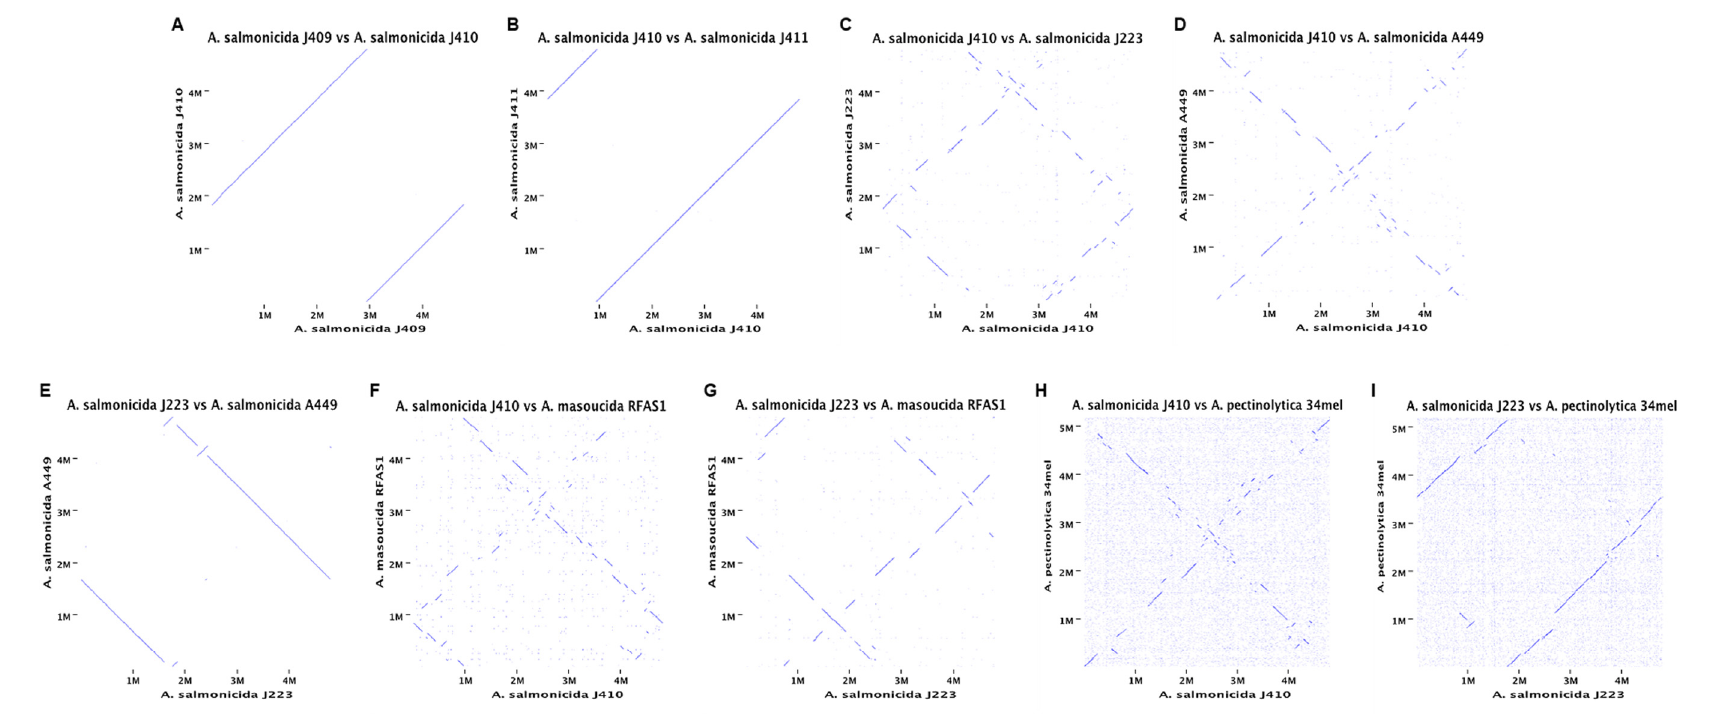
Figure 6. Whole-genome comparison synteny analysis. Genome sequences alignment to identify homology by synteny. ( A ) Comparison between A. salmonicda J409 vs. J410; ( B ) Comparison between A. salmonicda J410 vs. J411; ( C ) A. salmonicida J410 vs. A. salmonicida J223; ( D ) A. salmonicida J410 vs. A. salmonicida A449; ( E ) A. salmonicida J223 vs. A. salmonicida A449. ( F ) A. salmonicida J410 vs. A. masoucida RFAS1; ( G ) A. salmonicida J223 vs. A. masoucida RFAS1; ( H ) A. salmonicida J410 vs. A. peptinolytica 34mel; ( I ) A. salmonicida J223 vs. A. peptinolytica 34mel. Comparative analysis was performed by using CLC Bio.